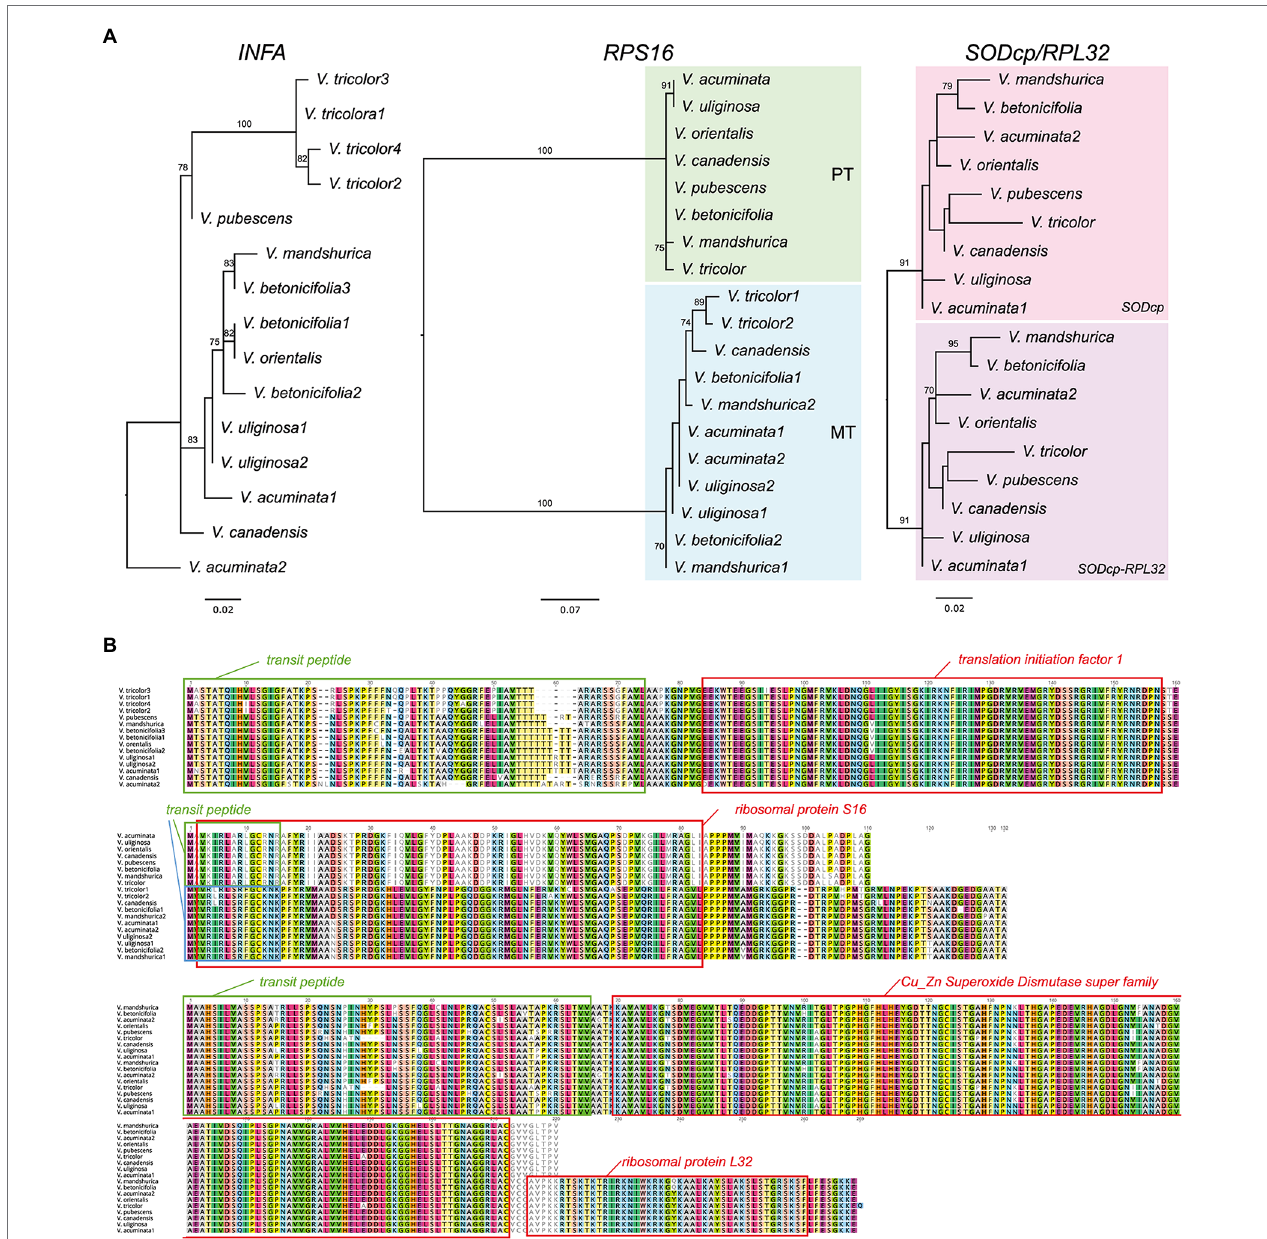
FIGURE 3 | Nuclear-encoded INFA , RPS16 , and SODcp-RPL32 genes in Viola . (A) Phylogenetic analysis of the nuclear-encoded genes from Viola . The numbers after each species indicate the paralogs of each nuclear gene. (B) Amino acid sequence alignment of the nuclear encoded INFA , RPS16 , and SODcp-RPL32 copies from Viola . Boxes indicate transit peptide (green and blue) and conserved